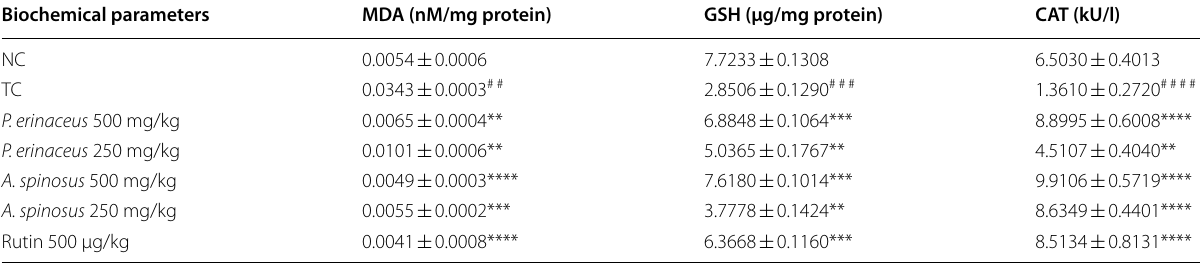
malondialdehyde; GSH =